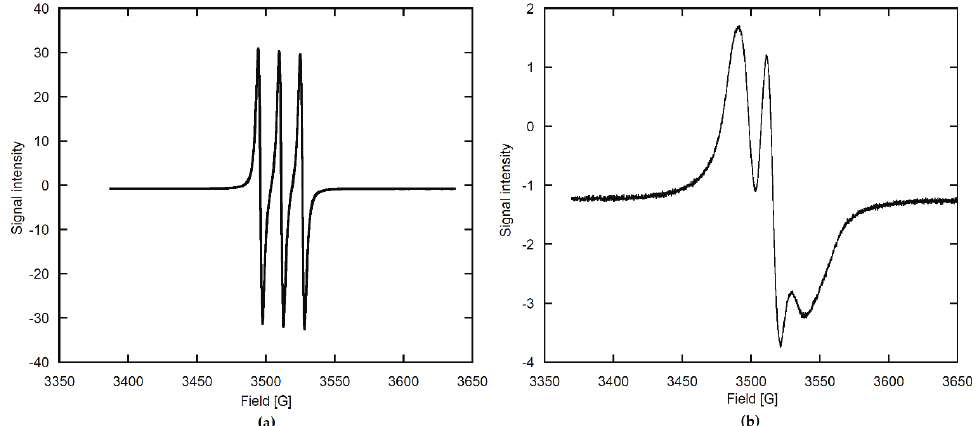
Figure 2. The EPR spectra of TEMPO in a very dilute solution and after adsorption on an anhydrous HA surface: ( a ) TEMPO in the 0.5 mM cyclohexane (CH) solution, unrestricted motion; ( b ) TEMPO adsorbed on HA83 from the 0.2 mM CH solution, with the apatite previously dehydrated at 200 °C, restricted motion.